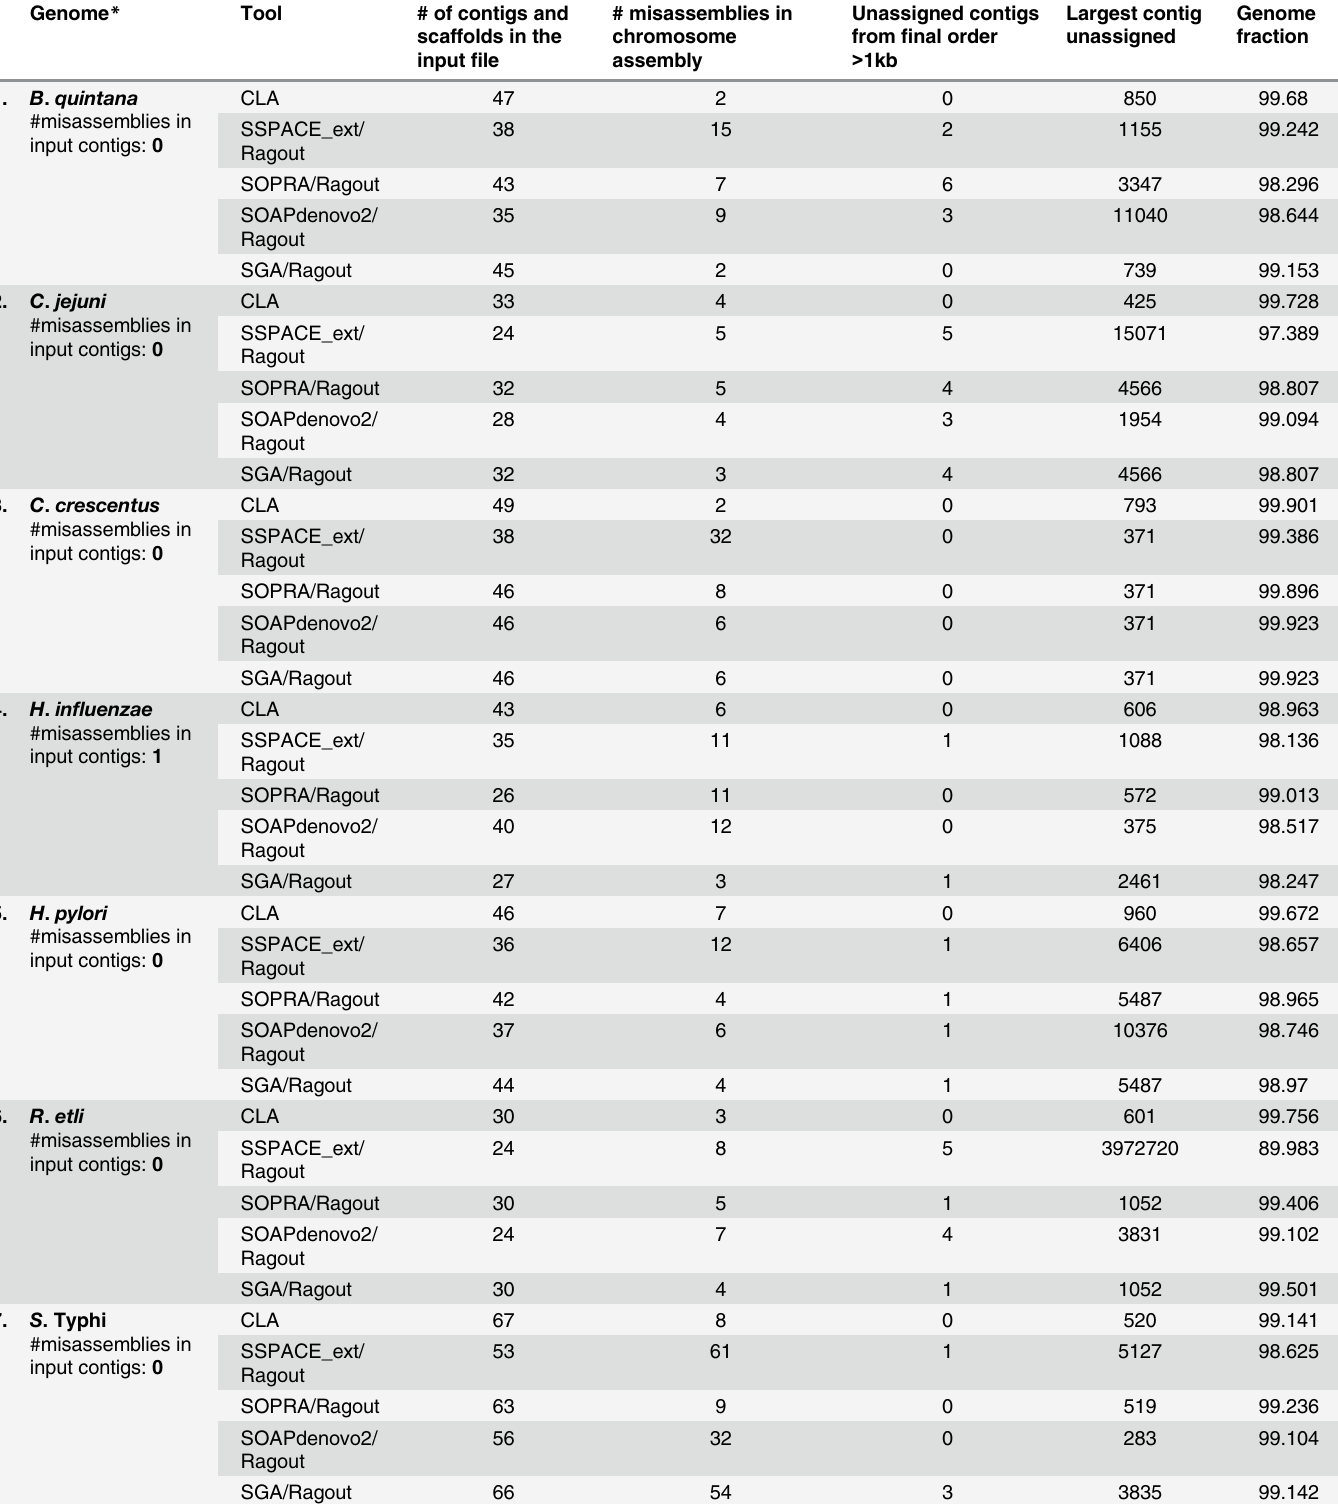
Table 5. Comparative statistics of CLA and Ragout ordering of scaffolds using simulated dataset. Genome